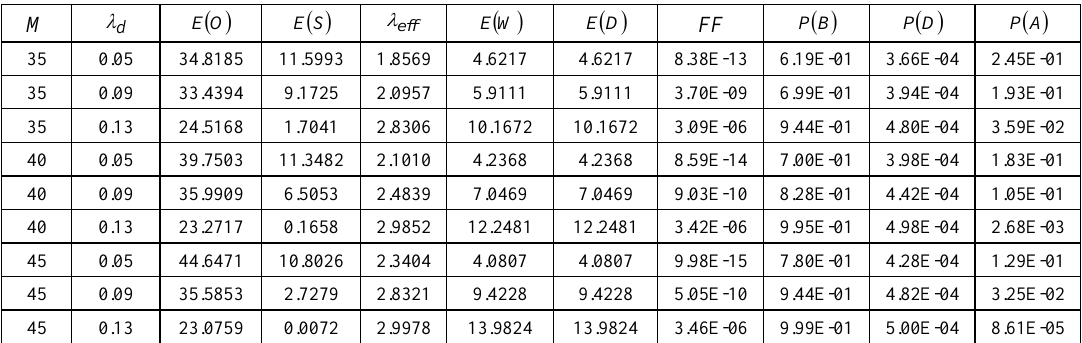
rate of operating machine ( )  . d